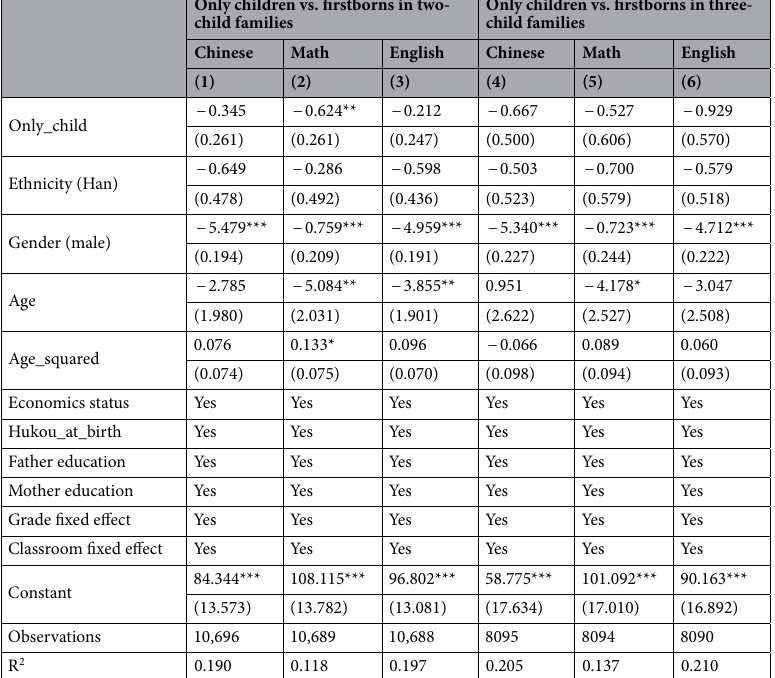
Table 4. The comparison of educational outcomes between only children and firstborns in two-child/three- child families. Notes: Standard errors in parentheses, adjusted for within-classroom clustering. * p < 0.10. ** p < 0.05. *** p <